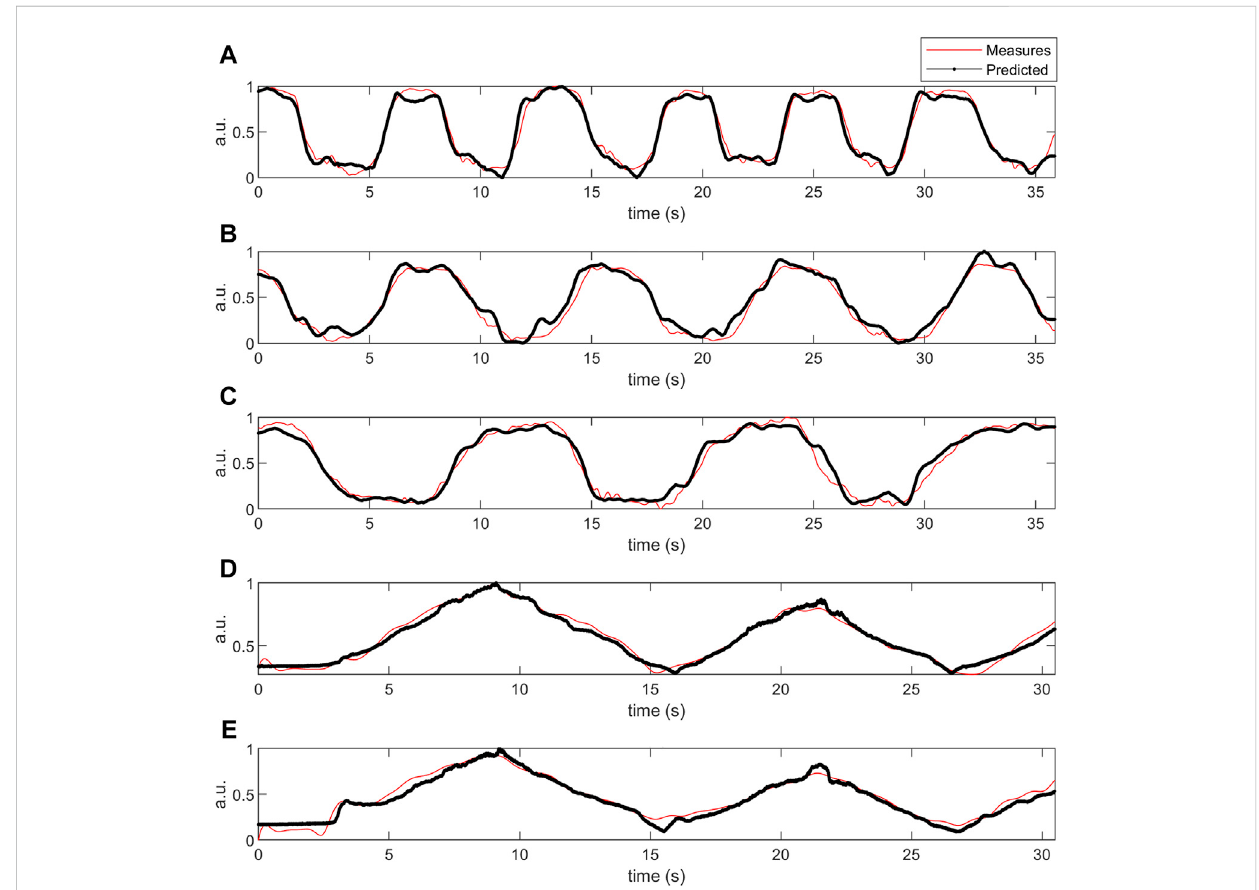
FIGURE 8 The measured and predicted force signals in different subjects from upper (D, E) and lower limb (A – C) test datasets (50% hold-out validation). The y-label data was normalized and had normalized arbitrary units (a.u.).